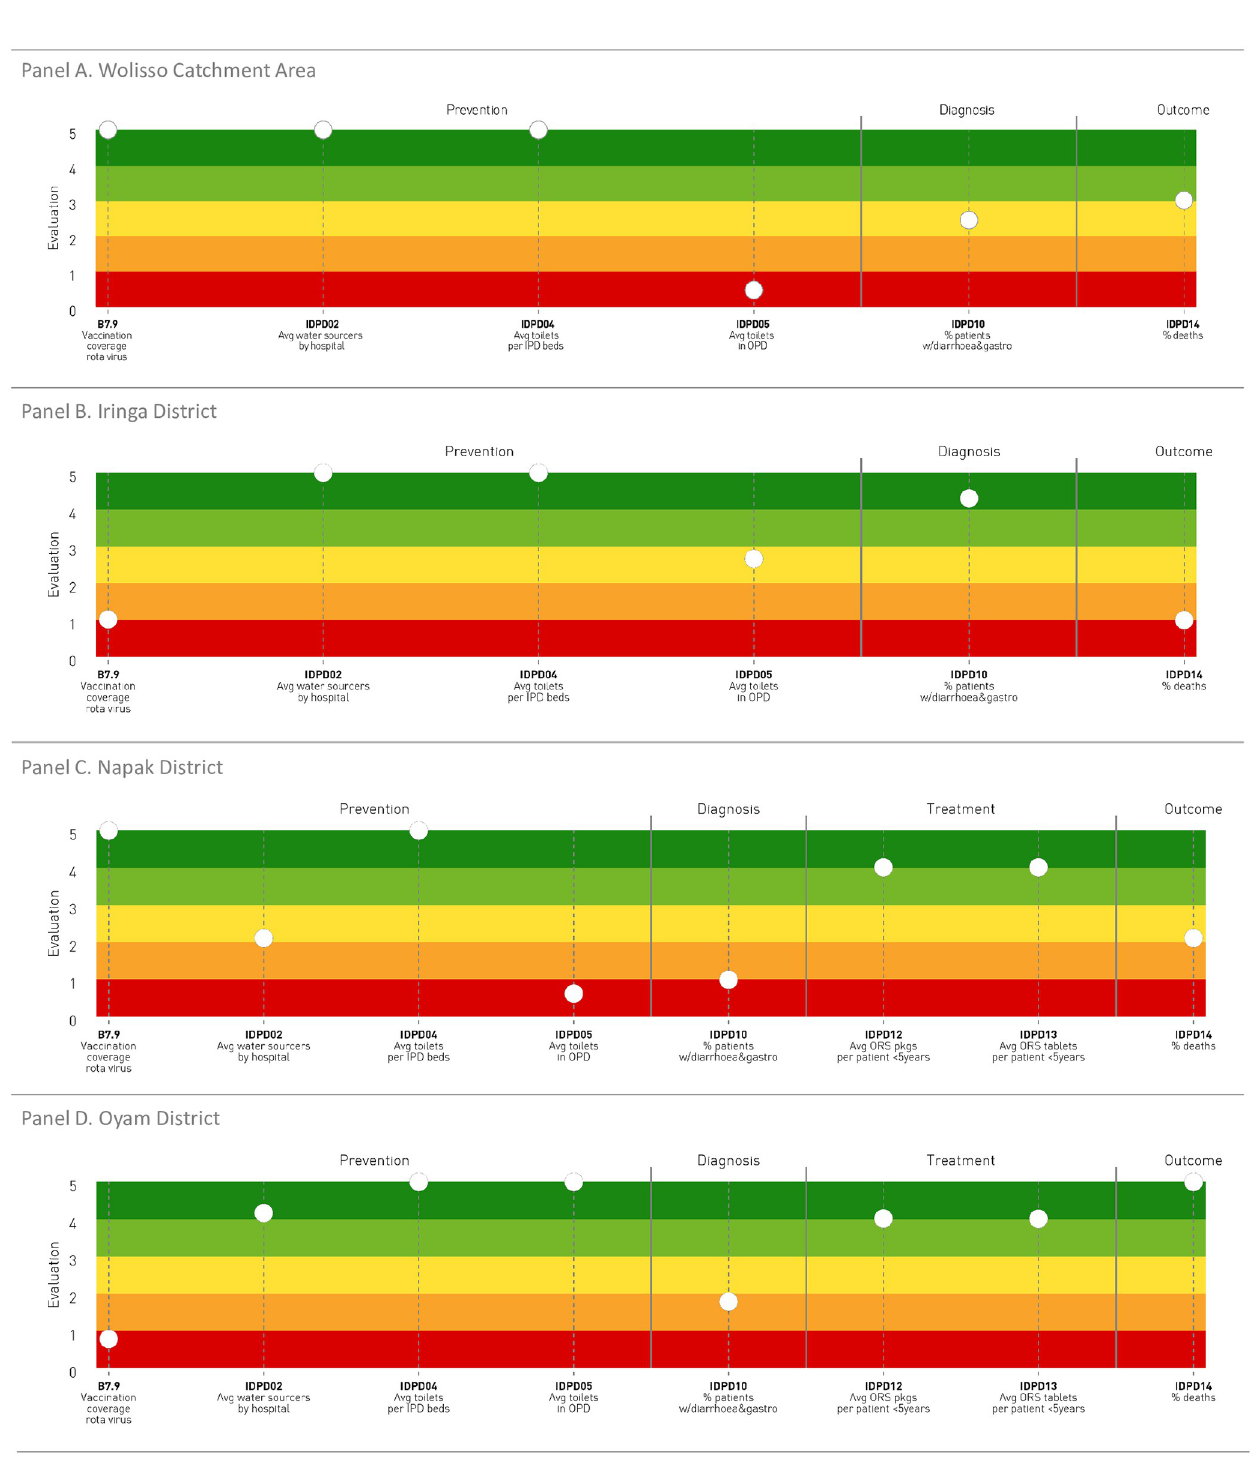
Fig 3. Gastroenteritis care pathway. Performance of care pathways related to gastroenteritis.